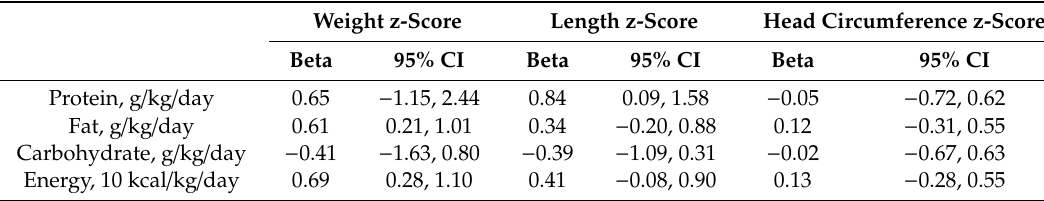
Table 3. Associations of nutrient intakes with anthropometry at term equivalent age ( n = 37). Weight z-Score Length z-Score Head Circumference z-Score Beta 95% CI Beta 95% CI Beta 95% CI Protein, g / kg / day 0.65 Fat, g / kg / day